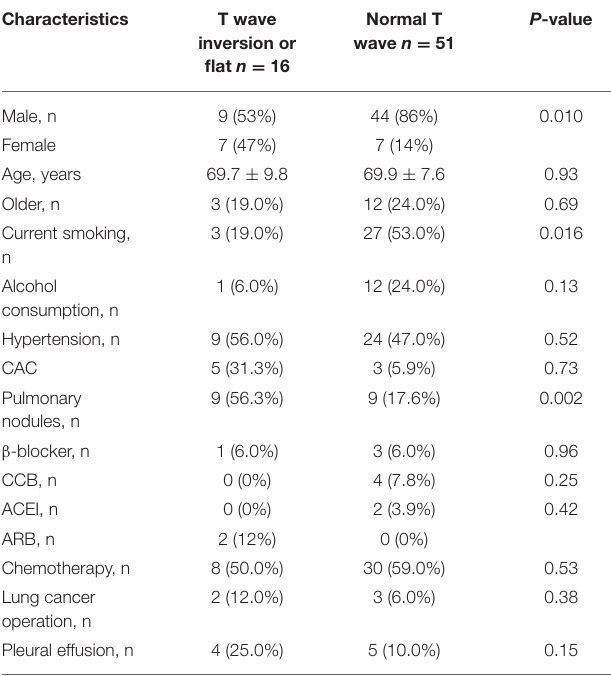
TABLE 1 | Characteristics of checkup people and patients with lung cancer. Characteristics